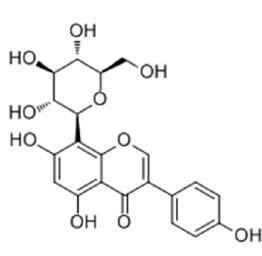
Figure 18. S tructure of puerarin.